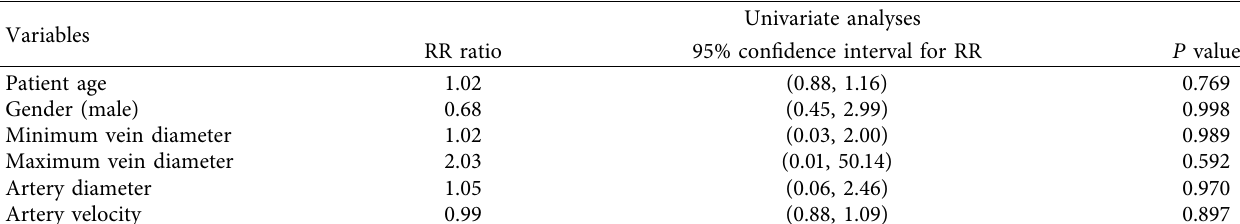
Table 7: Univariate analyses between demographics and vessel measurements on BBF